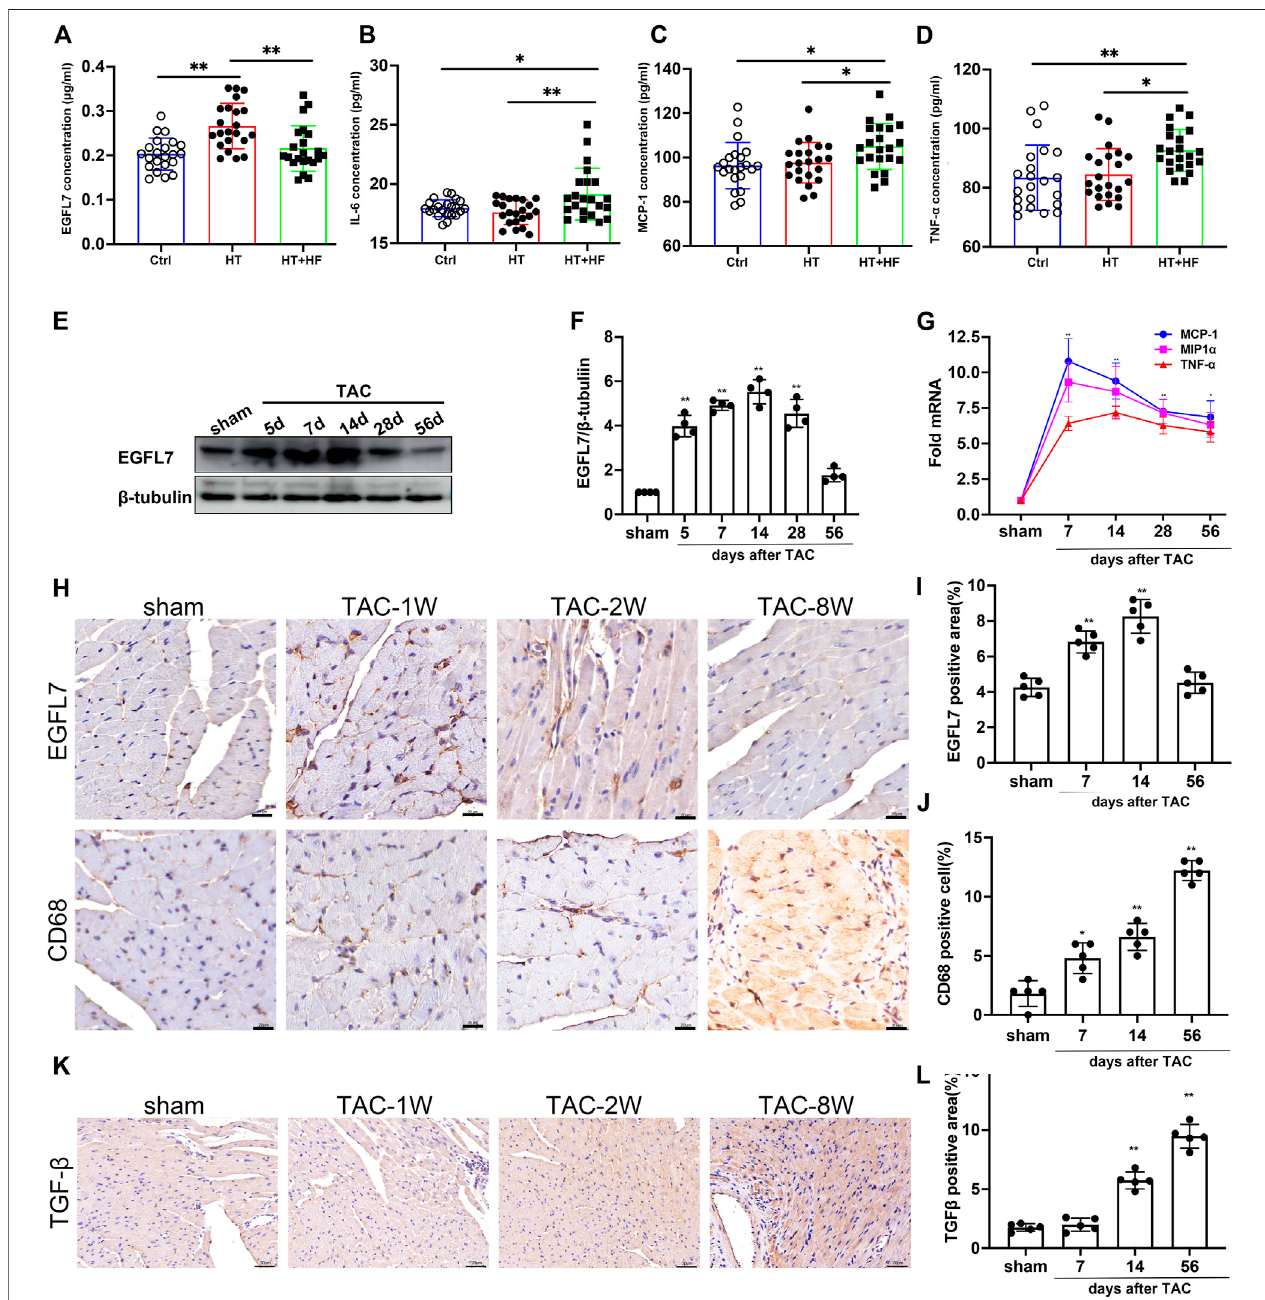
FIGURE 1 | EGFL7 is differently expressed in hypertrophic heart with or without heart failure and TAC-induced heart failure. Expression of EGFL7 (A) and IL-6 (B) , MCP-1 (C) , TNF- α (D) in serum of patients from healthy control, hypertension, and hypertension with heart failure. Data are presented as mean ± SD ( n = 22 for each group, * p < 0.05, ** p < 0.01 by one-way ANOVA followed mean ± SD by Tukey ’ s test). (E) C57BL/6J mice were subjected to either sham ( n = 6) or TAC operation and observed after 5, 7, 14, 28, 56 days ( n =6 respectively). Representative immunoblotsof EGFL7 expression in cardiac tissue among multiple time points post TAC. (F) Quantitative analysis expression of EGFL7. The values were normalized to β -tubulin. (** p < 0.01 vs. sham by one-way ANOVA followed by Tukey ’ s test). (G) Guantitative analysis of in fl ammatory cytokines mRNA of MCP-1, MIP1 α , TNF- α in heart tissue of TAC, values were normalized to GAPDH. (** p < 0.01 vs. sham by one- wayANOVAfollowedbyTukey ’ stest). (H) RepresentativeimmunohistochemicalstainingofEGFL7,CD68.Scalebar=20 μ m (I,J) QuantitativeanalysisofEGFL7,CD68 expression. Data were quali fi ed from 6 images per sample. Quanti fi cation of positive area % was calculated using ImageJ software. (* p < 0.05, ** p < 0.01 with sham by one-wayANOVAfollowedbyTukey ’ stest). (K,L) RepresentativeimmunohistochemicalstainingofTGF- β andquantitativeanalysis.Quanti fi cationofpositivearea%was calculatedusingImageJsoftware(** p < 0.01withshambyone-wayANOVAfollowedbyTukey ’ stest).Scalebar=20 μ